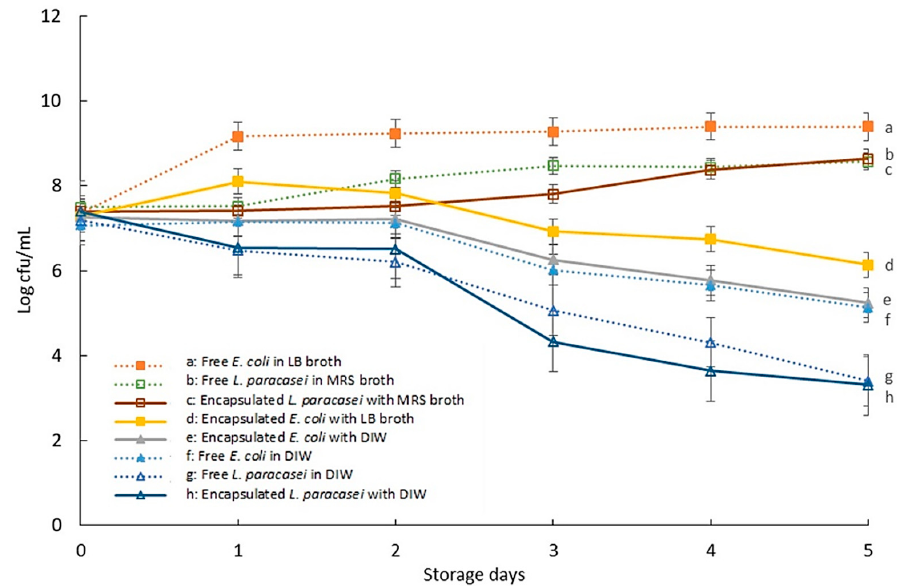
Figure 3. Bacterial growth during five days of storage for free bacterial cells and encapsulated bac ‐ terial cells in W/O droplet with or without nutrients. Bars represent mean ± SEM taken from 3 inde ‐ pendent experiments (N = 3) with 30 μ L of sample tested with Miles and Misra technique for each experiment.